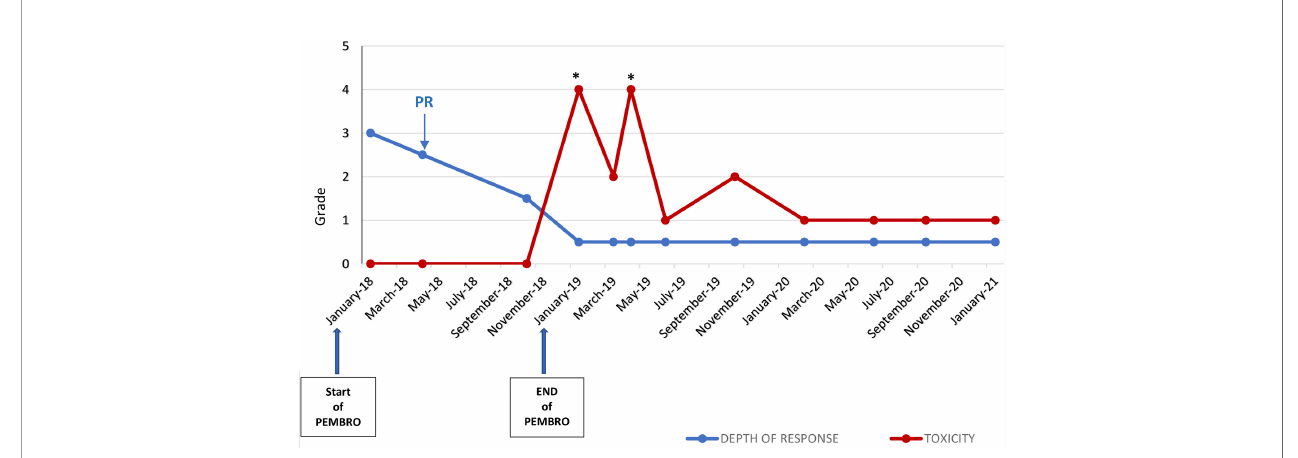
FIGURE 4 | Trend over time of the radiological response to pembrolizumab by RECIST Criteria version 1.0 and grade of gastrointestinal irAE (diarrhea) by CTCAE version 4.0 *Hospitalization; PD, Partial Response (according to RECIST v1.0); PEMBRO, pembrolizumab.